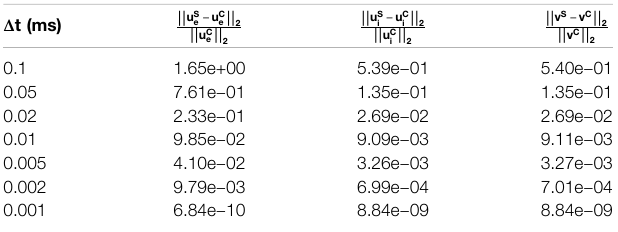
TABLE 2 | Difference between the solution of the coupled approach ( u C i , u C e , v C ) with Δ t (cid:2) 0 . 001 ms and the solution of the splitting approach ( u S i , u S e , v S ) for a number of different values of Δ t and with N it (cid:2)